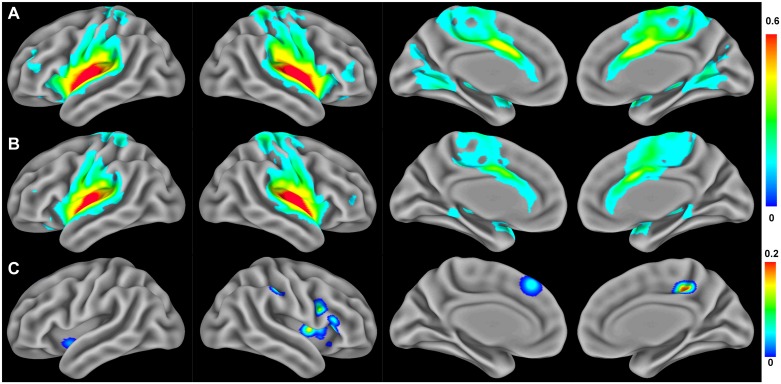
Resting-state functional connectivity networks of the posterior insula.(A) Functional connectivity patterns in healthy controls and (B) patients with CRPS (FDR < 0.01, within-group analysis). (C) Brain areas showing a significant reduction in posterior insula functional connectivity in patients with CRPS relative to healthy controls (P < 0.005 for permutation test, between-group analysis).